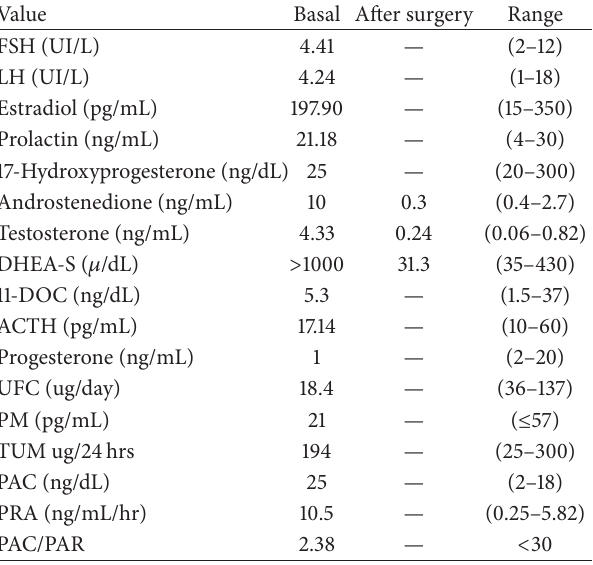
Table 1: Laboratory